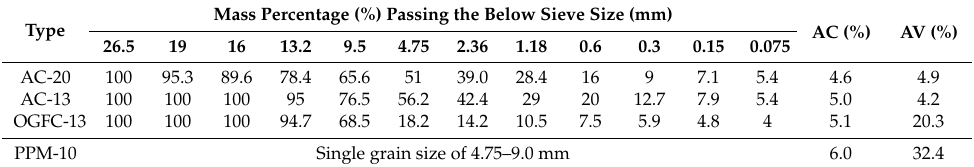
Table 2. Mix designs for different asphalt